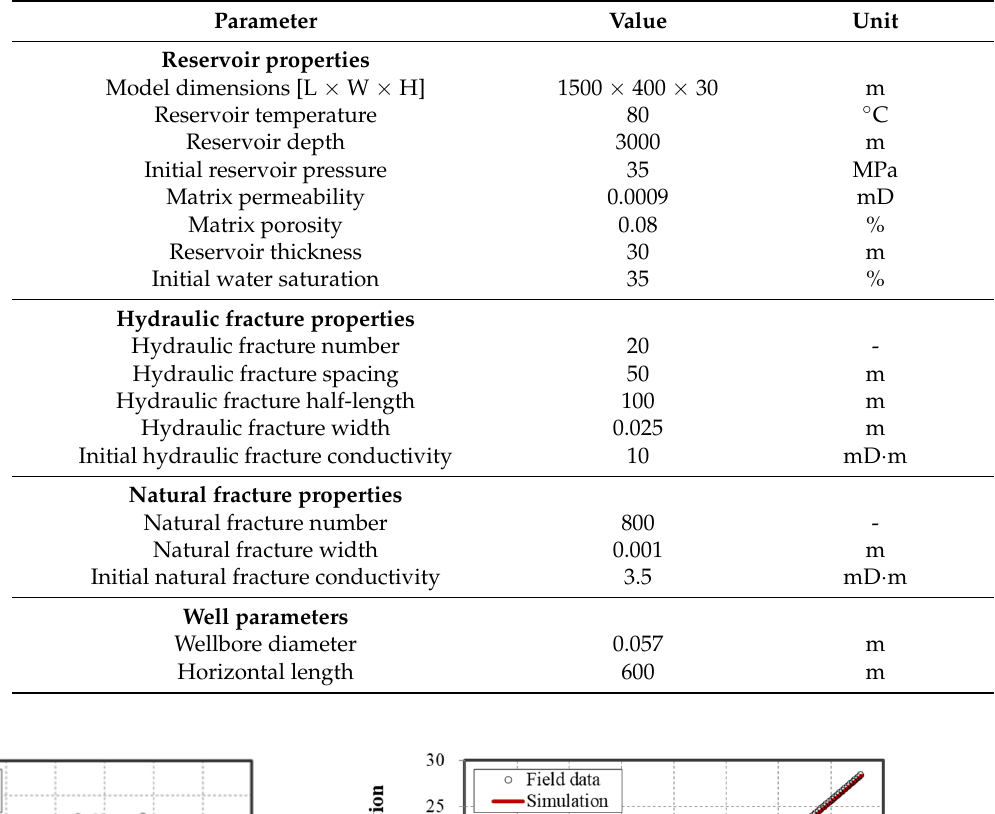
Table 2. Basic reservoir model parameters.